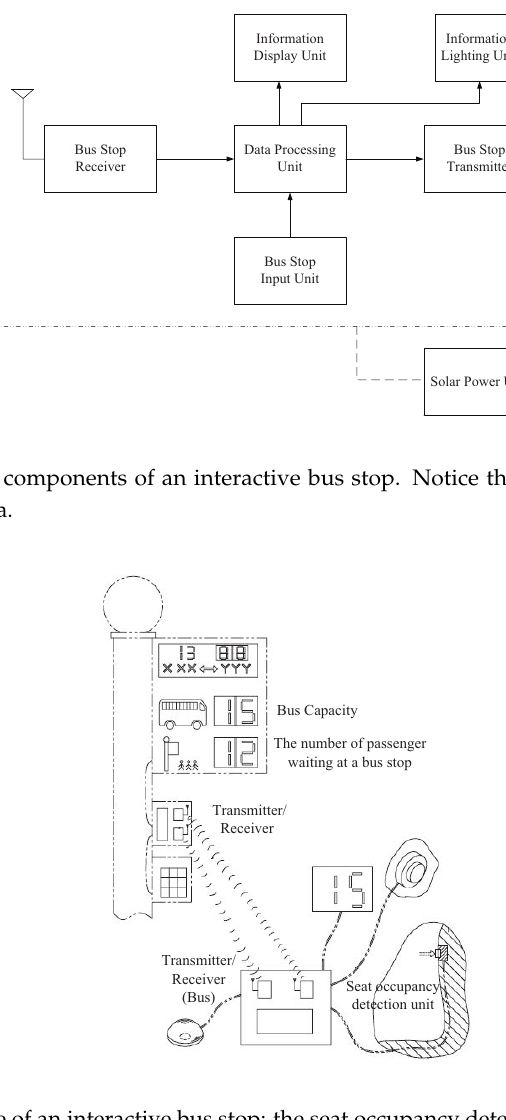
Figure 6. A prototype of an interactive bus stop: the seat occupancy detection unit consists of sensors and load